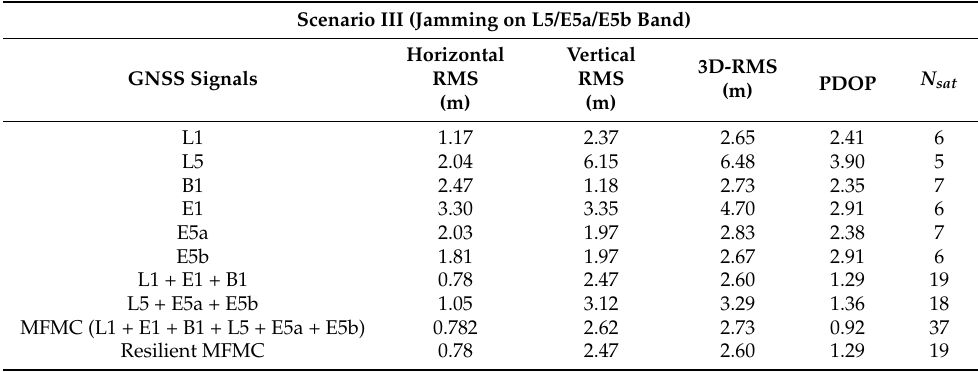
Table 6. Positioning accuracy of Scenario III with different signal